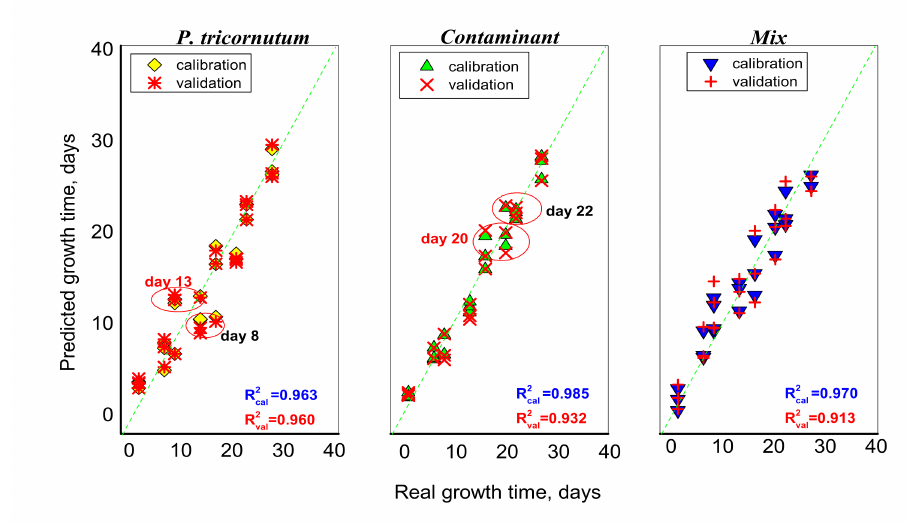
Figure 5. PLS correlation result for culture growth days and E-tongue